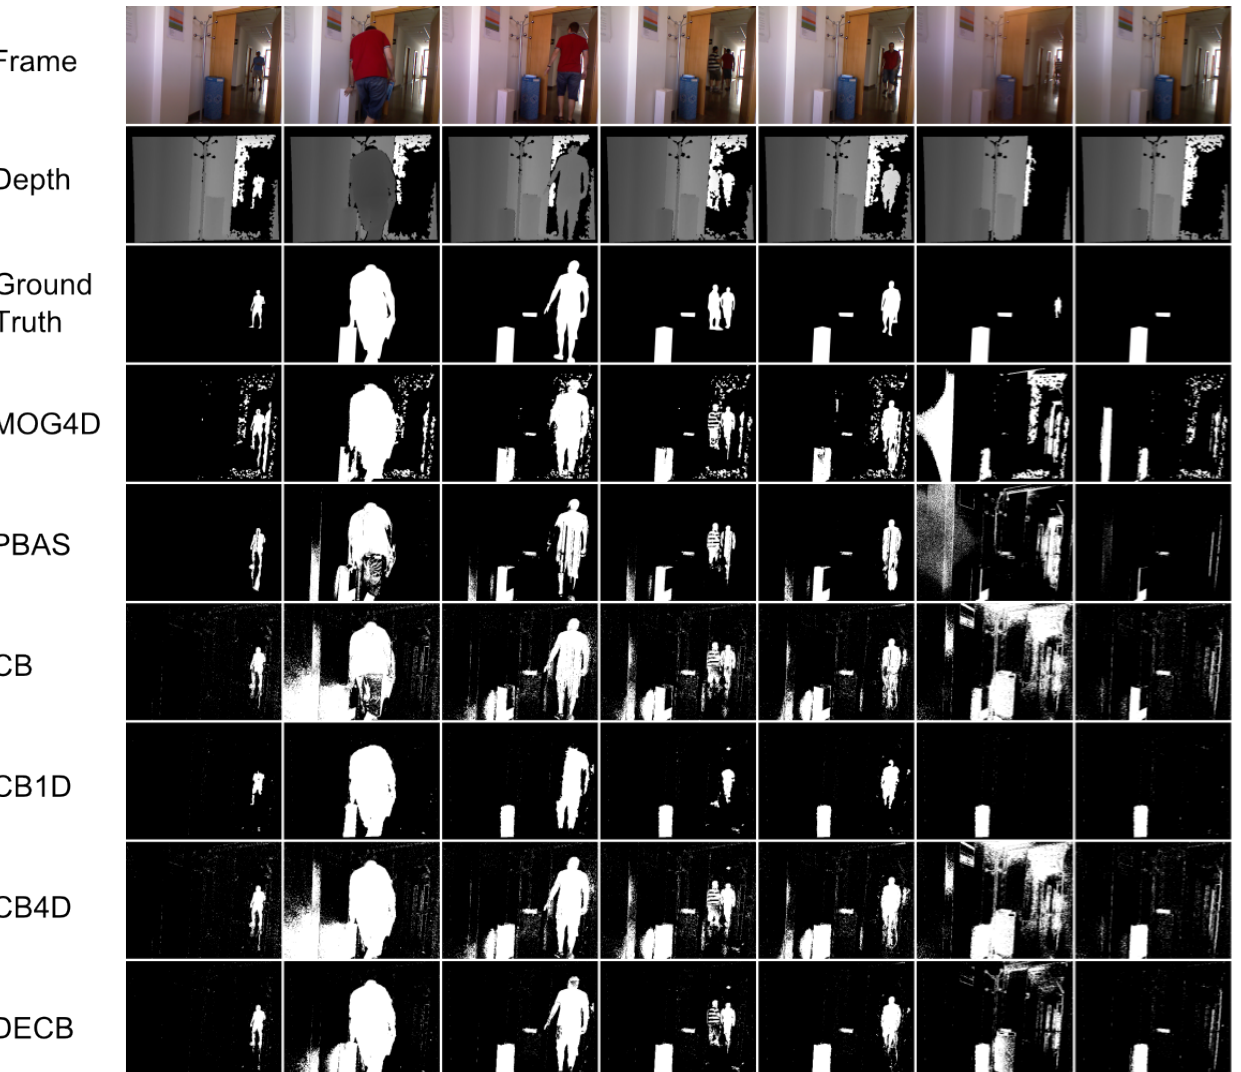
Figure 9. Results obtained from the test,